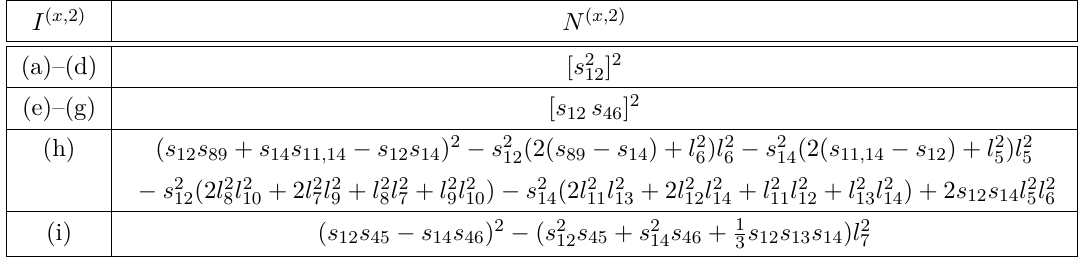
Table 2 . N = 8 supergravity numerator factors (from ref.